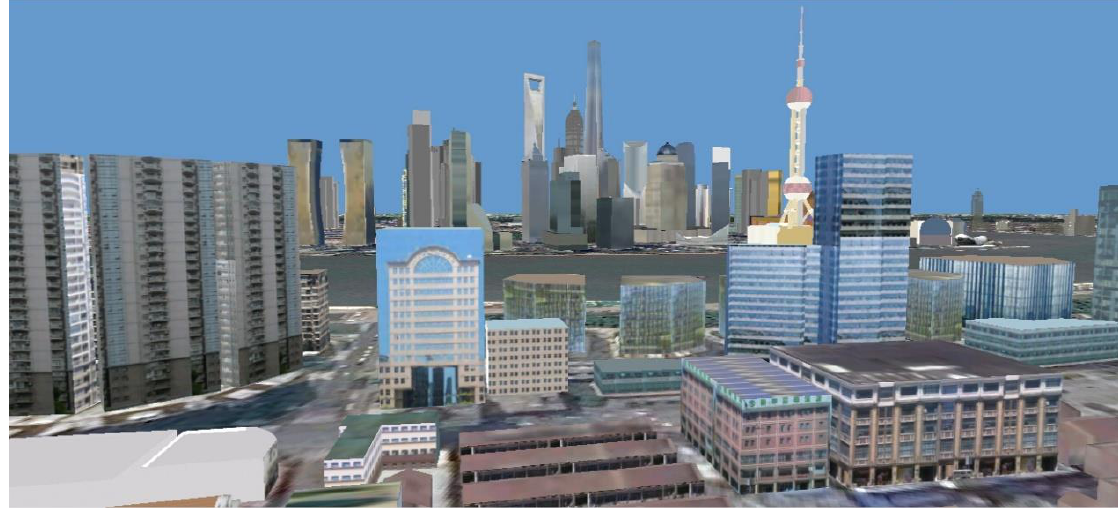
Figure 3. The process of building digital landscape